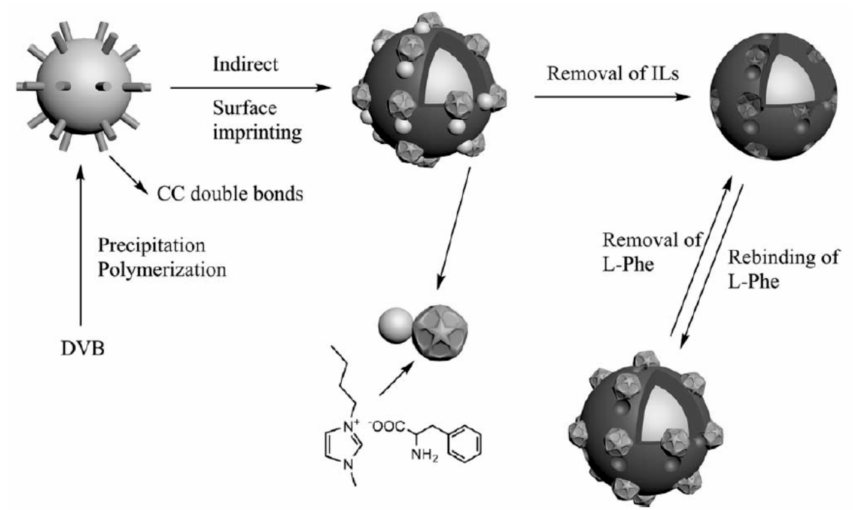
Figure 2. Protocol for the synthesis of MIPs for L -phenylalanine using 1-butyl-3-methylimidazolium α -aminohydrocinnamic acid salt [BMIM][Phe] as template. Reproduced from reference [67]